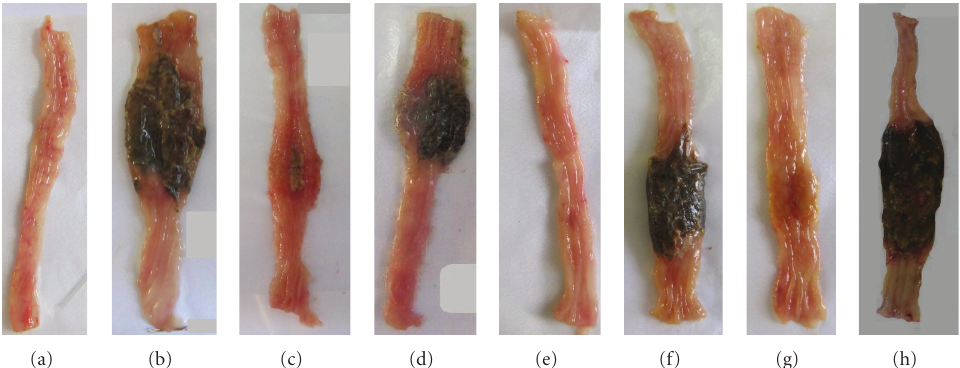
Figure 2: Macroscopic presentation of TNBS-induced colitis in rats. (a) normal rat, i.p; (b)TNBS-control rat, i.p (50 mg/kg); (c) dexamethasone-treated rat, i.p (1mg/kg); (d) cisapride-treated rat, i.p (2mg/kg); (e) normal rat, p.o; (f) TNBS-control rat, p.o (50mg/kg); (g) dexamethasone-treated rat, p.o (2mg/kg); (h) cisapride-treated rat, p.o (4mg/kg). Note the extensive hyperemia, edema, ulceration, visible enlargement, and necrosis of the colon in B, D, F, and H groups. In C and G groups the damage score of colon was significantly decreased.